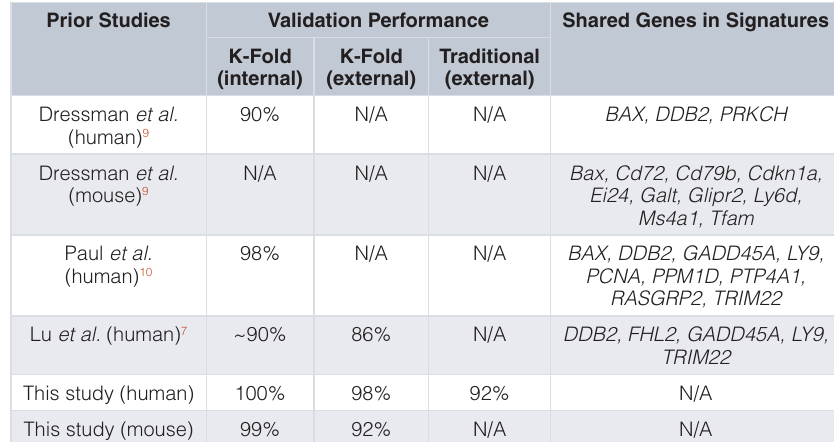
Table 5. Genes found in best performing signatures and previously derived